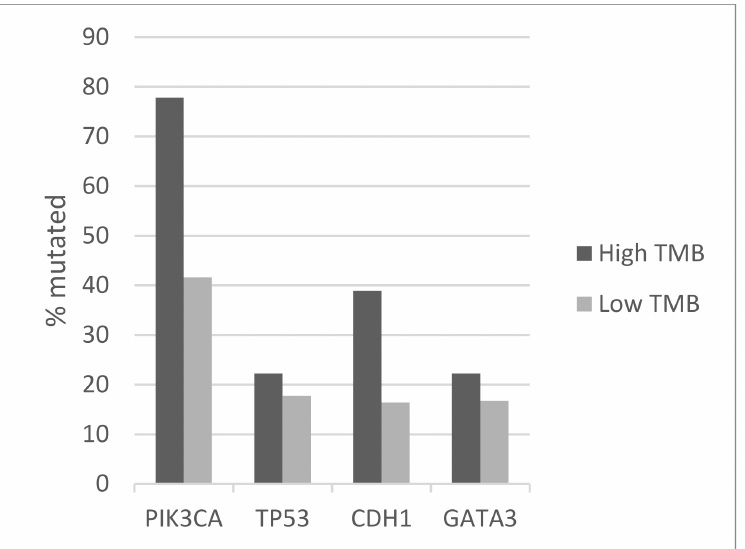
Figure 1. Prevalence of mutations in frequently mutated genes PIK3CA , TP53 , CDH1 , and GATA3 in luminal breast cancers according to TMB. High TMB group: >10 mutations/MB; low TMB group: ≤ 10 mutation/MB. The prevalence difference between the groups for PIK3CA and CDH1 mutations is statistically significant (Fisher’s exact test p = 0.003 and 0.02, respectively). The prevalence difference between the groups for TP53 and GATA3 mutations is not statistically significant (Fisher’s exact test p = 0.54 and 0.52, respectively). Data are from TCGA. TMB—tumor mutation burden.